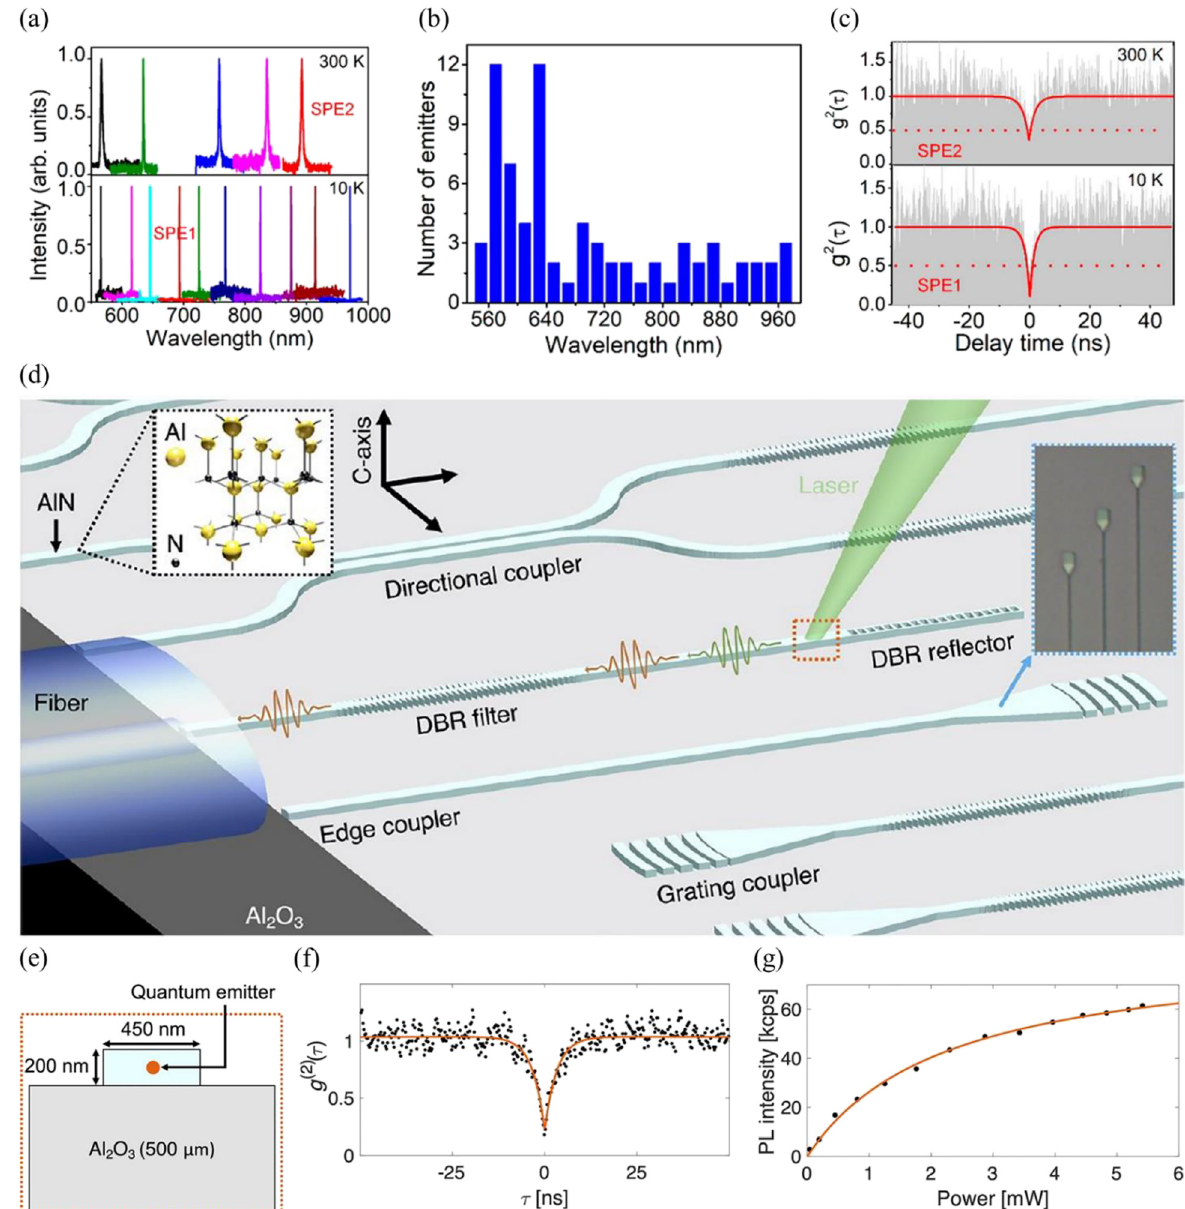
Figure 6: AlN-based quantum emitters. (a) Photoluminescence spectra measured at 300 K (top panel) and 10 K (bottom panel). (b) Histogram showing the emission wavelength distribution of 74 emitters. (c) Normalized autocorrelation data for selected single-photon emitters (SPE1 and SPE2). g (2) (0) of 0.10 ± 0.05 and 0.34 ± 0.05 are obtained for SPE1 at 10 K and SPE2 at 300 K, respectively. Red dotted lines indicate the classical threshold of 0.5. (a) – (c) Adapted with permission from [126], copyright (2020) American Chemical Society. (d) Schematic of quantum emitter integrated within the photonic integrated circuits. Inset on the left: wurtzite crystal structure of AlN. Inset on the right: microscopic image of the fabricated AlN waveguides and grating couplers. (e) Cross-section of single-mode AlN-on-sapphire waveguide, with quantum emitter embedded within AlN waveguide (not necessarily to be right in the center). (f) Autocorrelation measurement of the emitter via waveguide collection, showing g (2) (0) = 0.21 ± 0.08. (g) Photoluminescence intensity saturation responseof the emitter, with saturation rate of >8.6 × 10 4 countsper second. (d) – (g) Adapted with permission from [127], copyright (2020) American Chemical enables the reduction of photodetector dark current by The pyroelectric property of AlN also makes it a suit- 10 times, and doubling of the responsivity from 0.3 to able material for MEMS-based thermal detector for sensing 0.6 mA/W. in IR wavelength [64, 65, 71, 111, 112]. Differentiating from